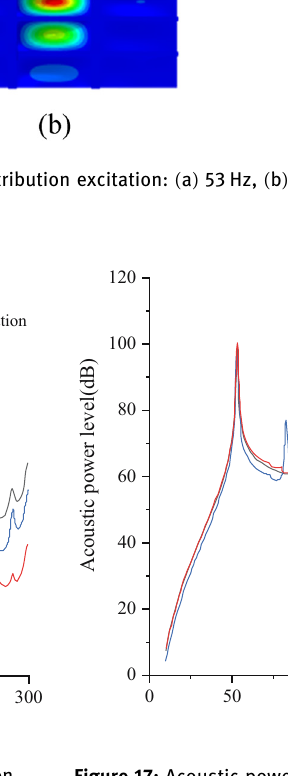
Figure 16: Mean square velocity level under di ff erent excitation. Figure 17: Acoustic power level under di ff erent